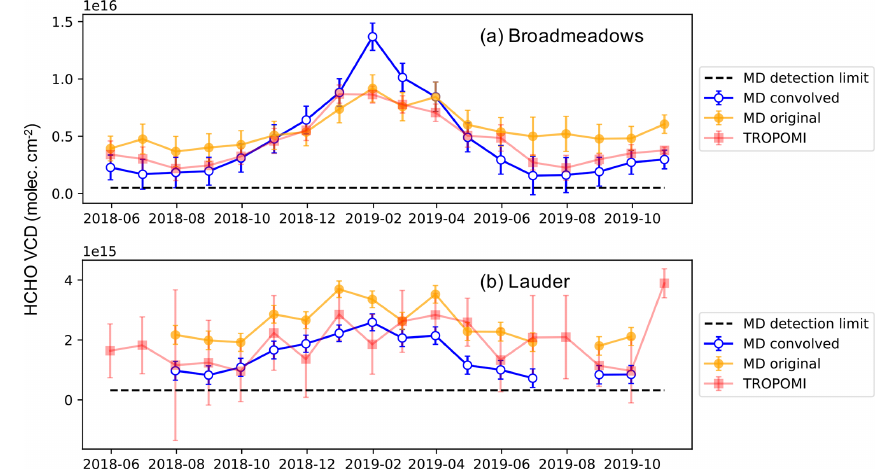
Figure 8. Time series comparison of monthly mean formaldehyde columns from TROPOMI and the MAX-DOAS between May 2018 and November 2019 at (a) Broadmeadows and (b) Lauder. Both the original (orange) and convolved (blue and white, i.e. accounting for different retrieval a priori and sensitivities) MAX-DOAS columns are shown.